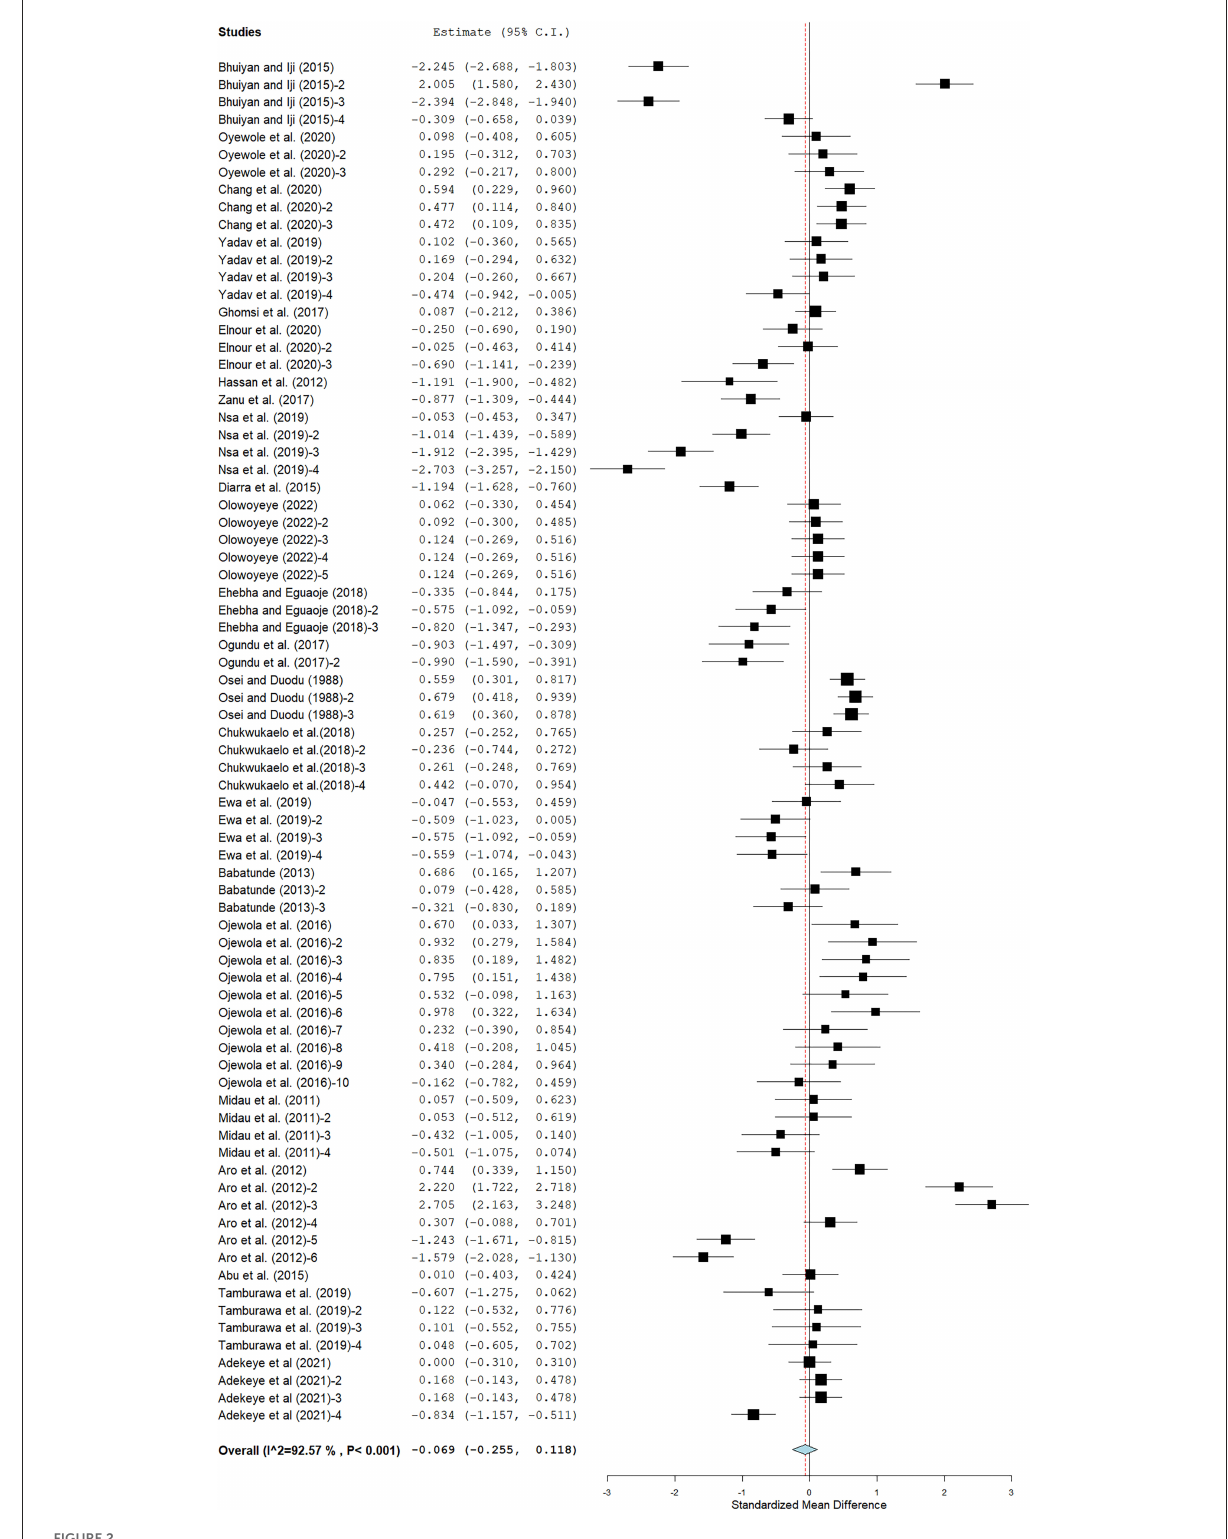
FIGURE2 Modified error bar (MEB) of the impact of cassava on feed intake of broiler chickens. The thick vertical line is the line of no effect. Plots to the left of the solid vertical line indicate a decline in feed intake, whereas plots to the right mean an increase in feed